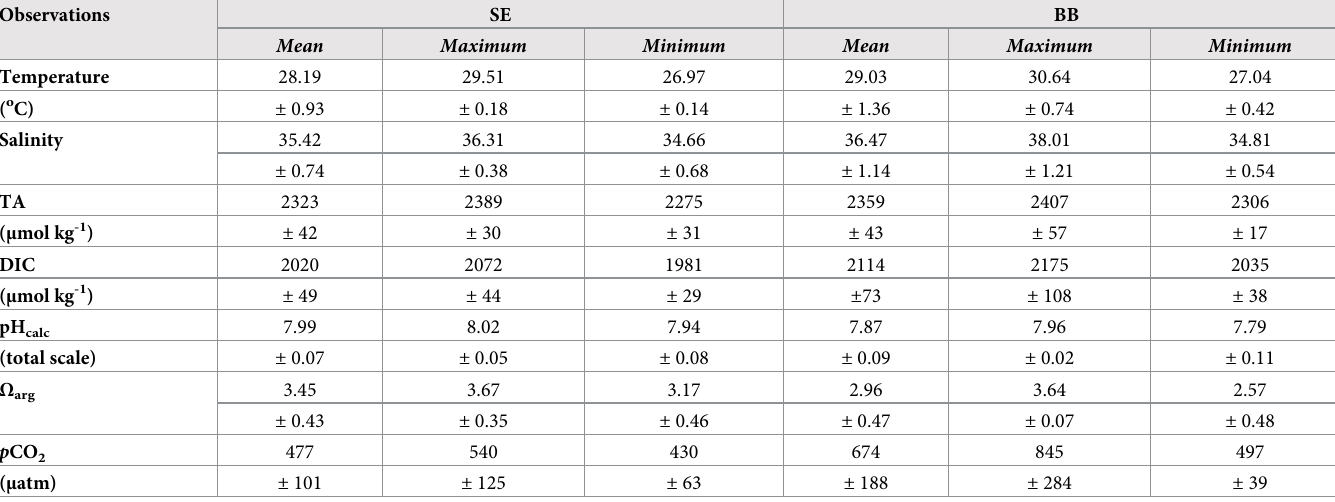
Table 1. Maximum and minimum monthly means ( ± one standard deviation) for each parameter from Fig